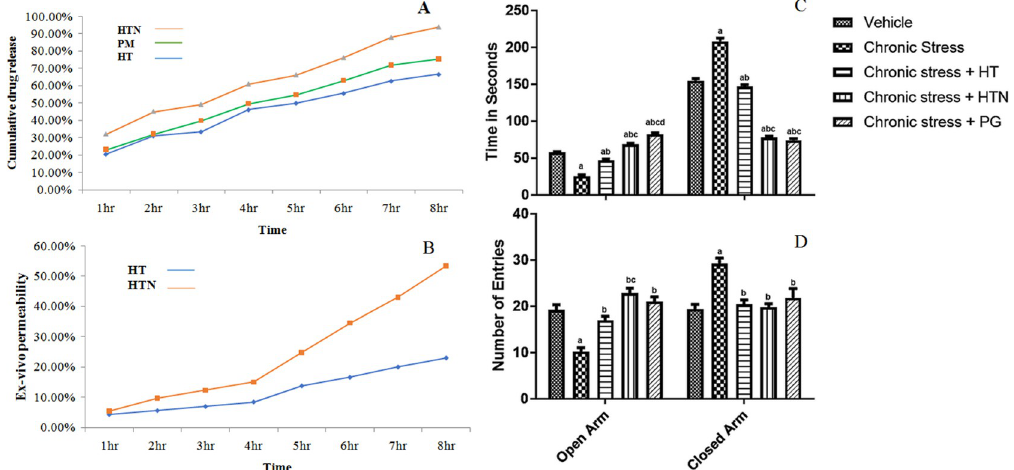
Fig 6. In-vitro dissolution study of HT, PN, and HTN (A), Ex-vivo permeability of HT and HTN, and in-vivo activity of HTN (C and D). Values are mean ± S.E.M. (n = 5). Where a: P < 0.05 vs. Vehicle, b: P < 0.05 vs. Chronic stress, c: P < 0.05 vs. Chronic stress + HT and d: P < 0.05 vs. Chronic stress + HTN. One-way ANOVA, followed by post hoc Bonferroni’s multiple comparison test.